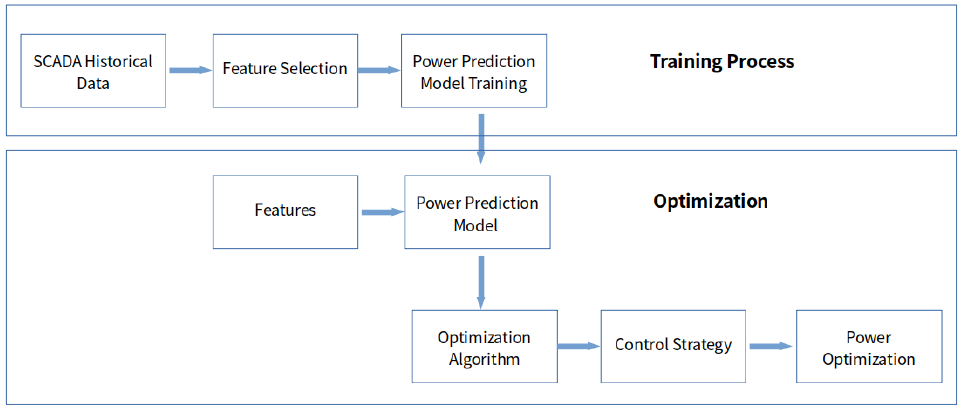
Figure 2. Overview of entire framework.